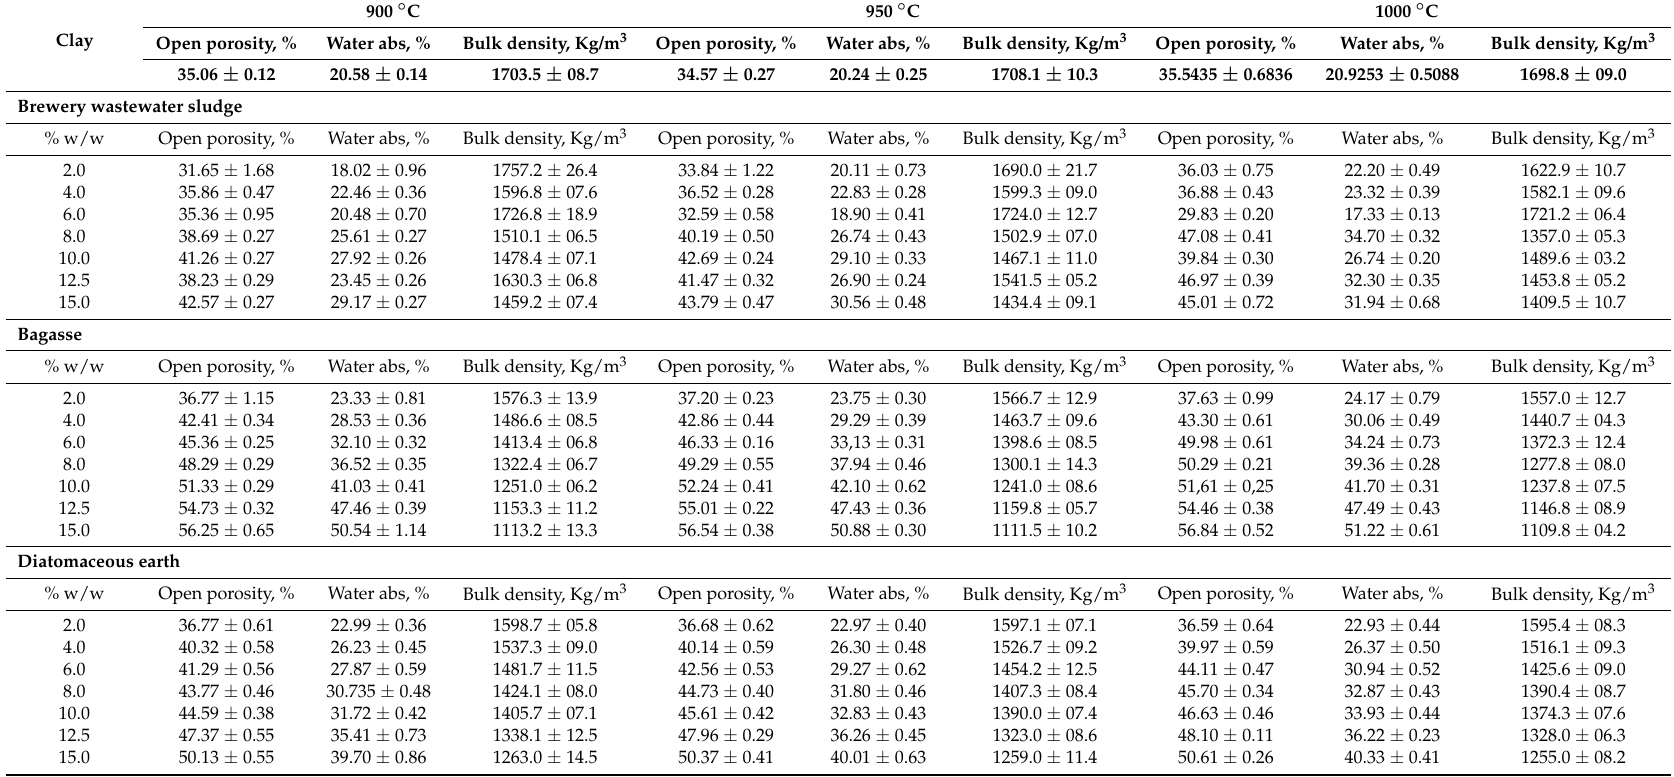
Table 4. Open porosity, bulk density and water absorption of sintered